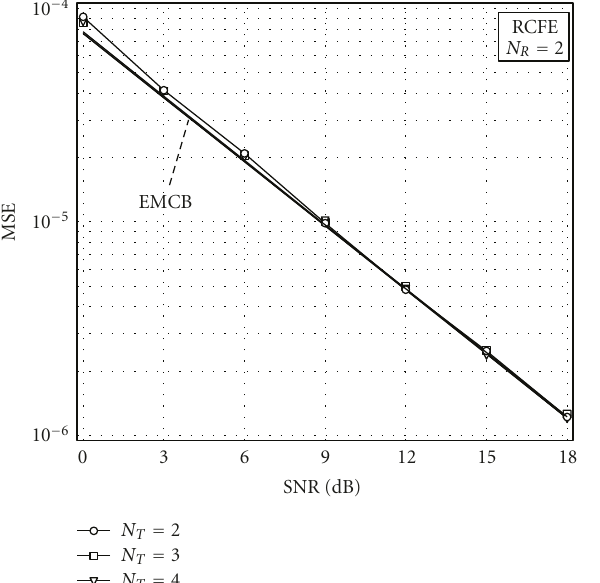
Figure 2: Accuracy of RCFE versus SNR with N T = 2,3,4 and N R = 2.